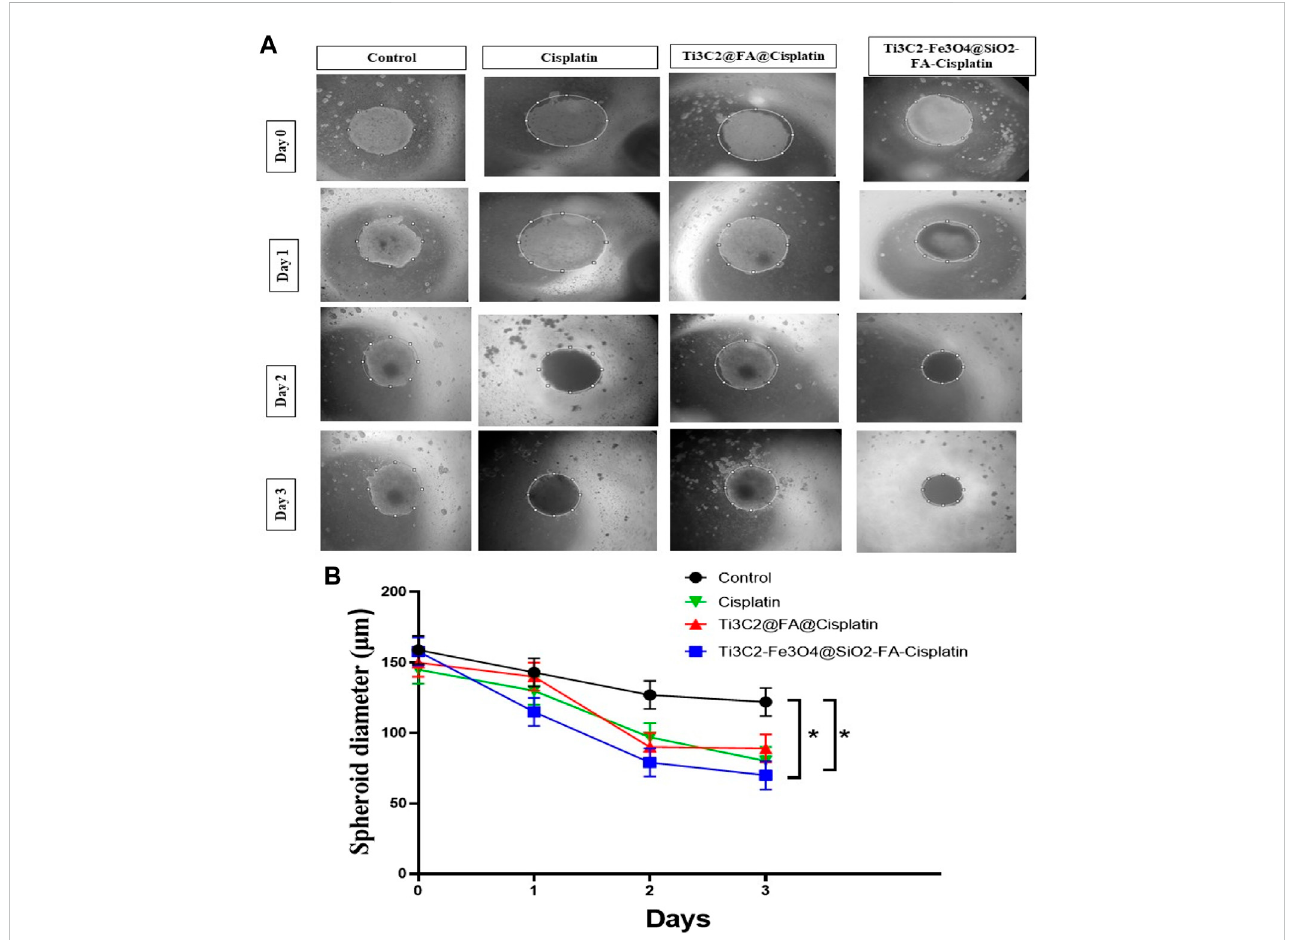
FIGURE 12 The formation of TC1, Ti 3 C 2 @FA@Cisplatin, and Ti 3 C 2 -Fe 3 O 4 @SiO 2 -FA-Cisplatin -induced spheroid cells in response to Cisplatin and Ti 3 C 2 -Fe 3 O 4 @ SiO 2 -FA-Cisplatin treatments. These micrographs illustrate the effects of Cisplatin, Ti 3 C 2 @FA@Cisplatin, and Ti 3 C 2 -Fe 3 O 4 @SiO 2 -FA-Cisplatin on TC1 spheroids (A) . A quantitative assessment of the changes in spheroid sizes (B)